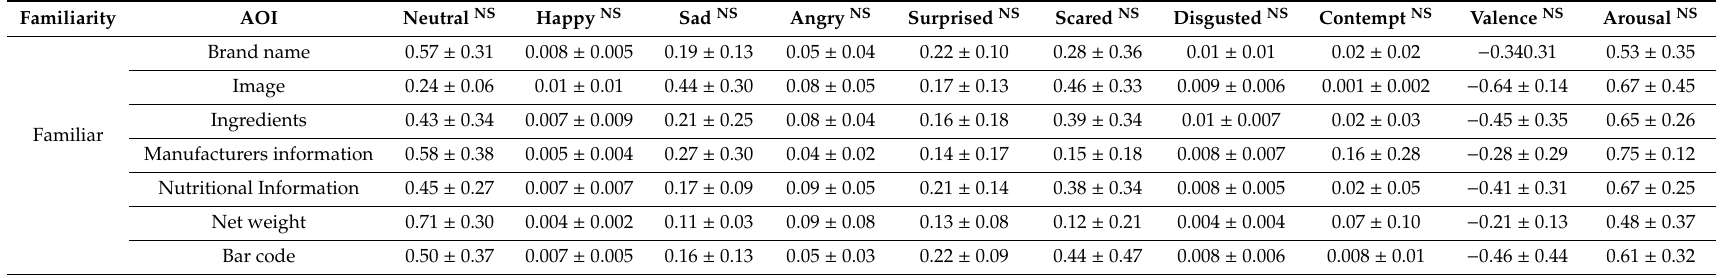
Table 5. Mean values (top) and standard deviation (bottom) of FaceReader ™ outputs during the fixation on a defined AOI in familiar packaging